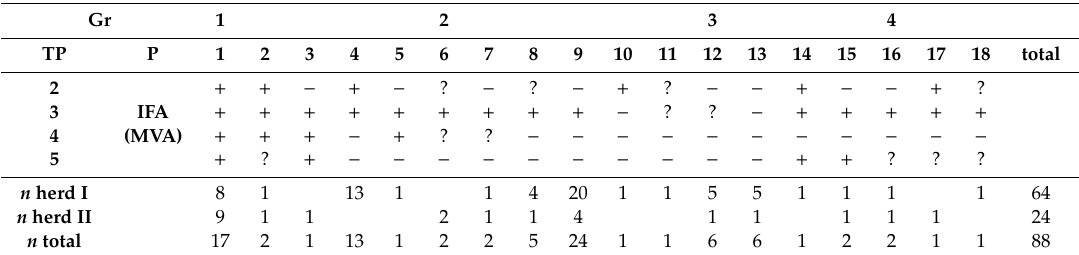
Table 2. Summary of individual antibody titres over time after prime-boost MVA vaccination against cowpox in